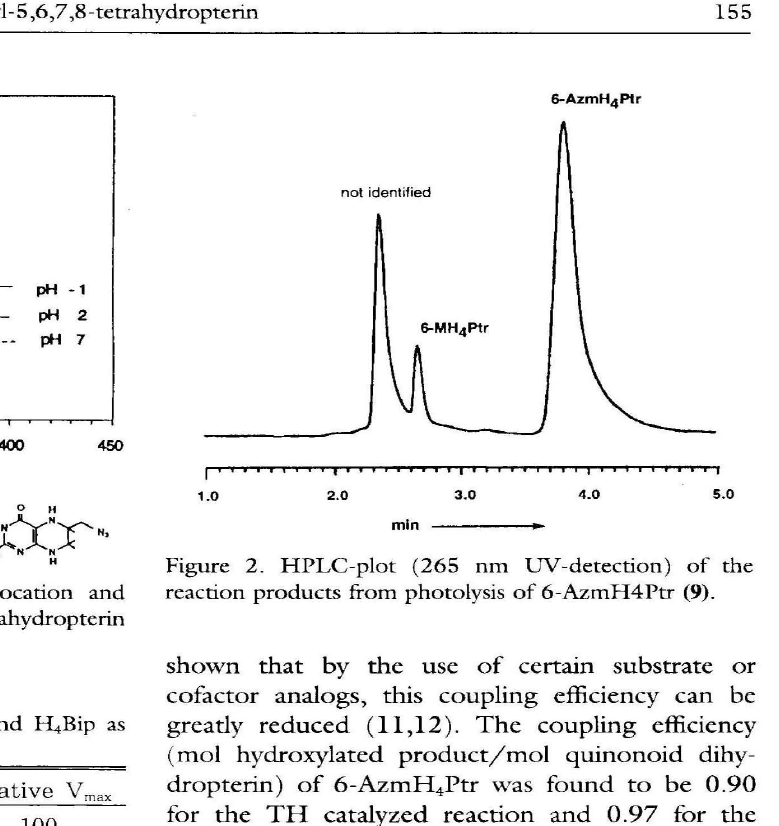
Table 1. 1(", and V max for 6-AzmH.Ptr (9) and H.Bip as Cofactors for TH and P AH